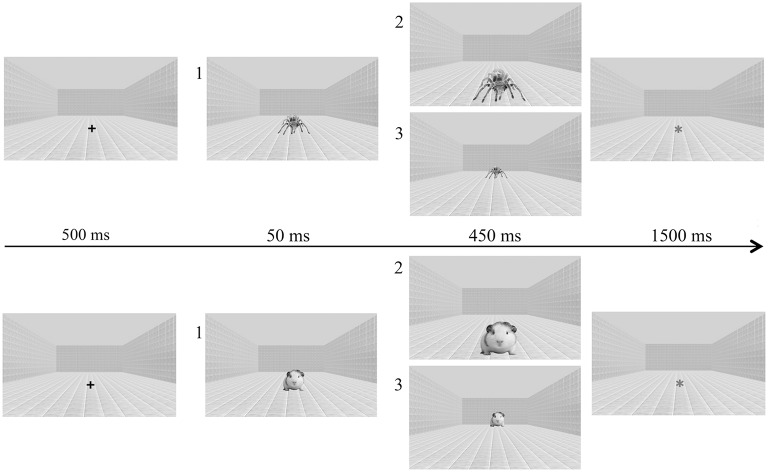
Example of experimental stimuli (threatening: upper row; non-threatening: lower row) and of trial sequence. Frame sequence 1–2 displays approaching stimuli, whereas frame sequence 1–3 displays receding stimuli. Here, images are presented in gray-scale, but they were employed in the natural colored version for the experiment. The trial sequence started with a fixation cross (+), followed by stimuli displaying an approaching or a receding motion. Finally, the stimulus was replaced by an asterisk (*).